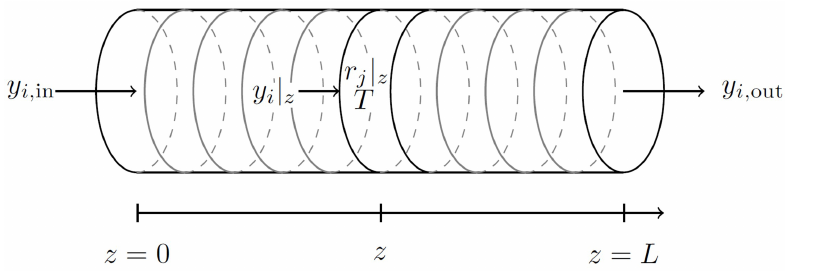
Figure 6. Schematic representation of the axial domain discretization, exemplary for 10 uniformly distributed